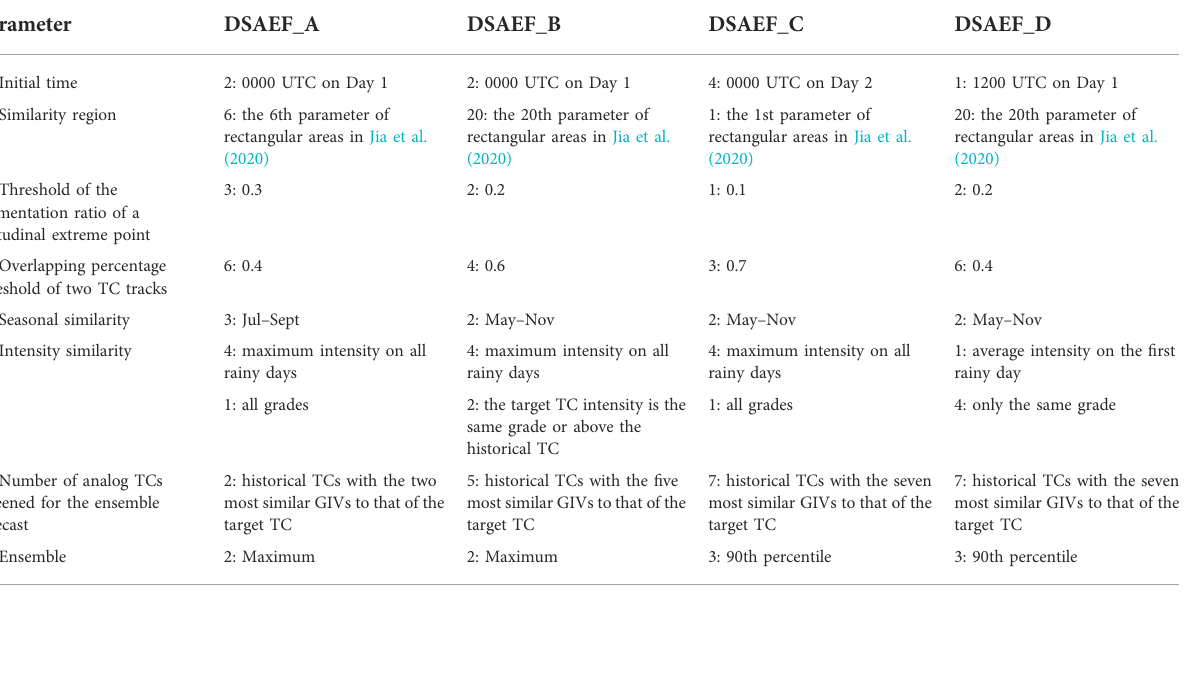
TABLE 2 Parameter values of the best scheme in the four experiments.